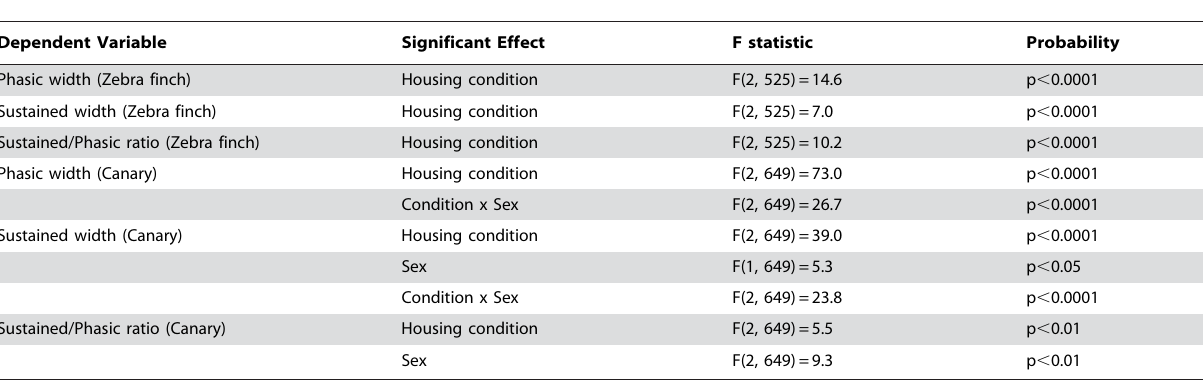
Table 2. Significant results of ANOVAs for all birds tested under breeding